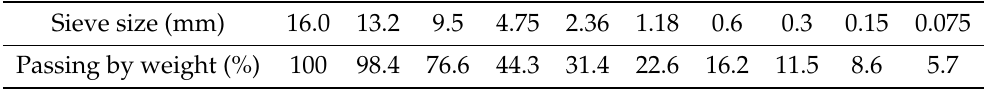
Table 1. Aggregate gradation for the asphalt